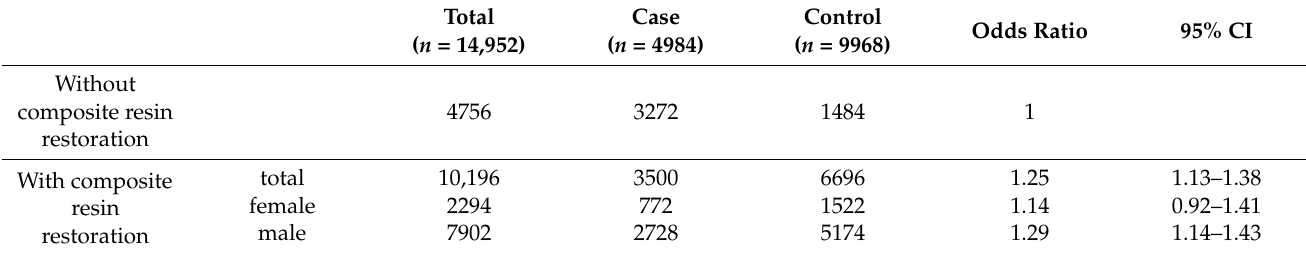
Table 2. Odds ratio for composite resin restorations of those with a diagnosis of ADHD.